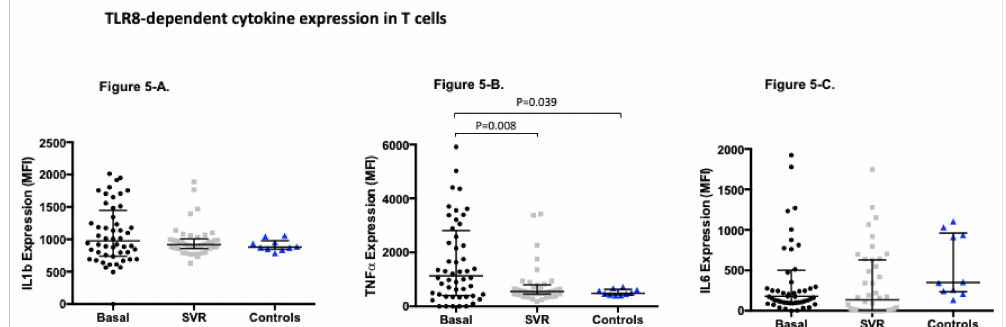
Figure 5. TLR8-dependent cytokine expression in T cells measured as mean fluorescence intensity (MFI) (median (IQR)) in HCV patients pre and post treatment and healthy controls: ( A ). TLR8-dependant IL1b expression in T cells in HCV patients pre-treatment MFI (974.2 (741.4–1448.0)) compared to post-treatment MFI (917.4 (859.5–1005.0)) p = 0,141; and compared to controls MFI (881.2 (846.6–976.6)) p = 0.254. ( B ). TLR8-dependant IL6 expression in T cells in HCV patients pre-treatment MFI (178.9 (102.1–502.1)) compared to post-treatment MFI (136.0 (4.79–629.8)) p = 0.513; and compared to controls MFI (351.0 (235.5–960.3)) p = 0.702. ( C ). TLR8-dependent TNF alfa expression in T cells in HCV patients pre-treatment MFI (1133.0 (400.0–2809.0)) compared to post-treatment MFI (552.9 (450.6–796.9)) p = 0.008; and compared to controls MFI